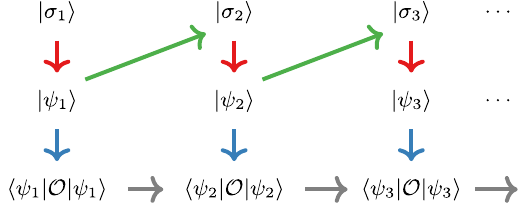
FIG. 7. Illustration of the METTS algorithm. Red arrows indicate imaginary-time evolution of product states j σ i i into METTS j ψ i i . Green arrows indicate the collapse step, and blue arrows indicate performing measurements of observables. This procedure yields a time series of measurements h ψ i j O j ψ i i indicated by gray